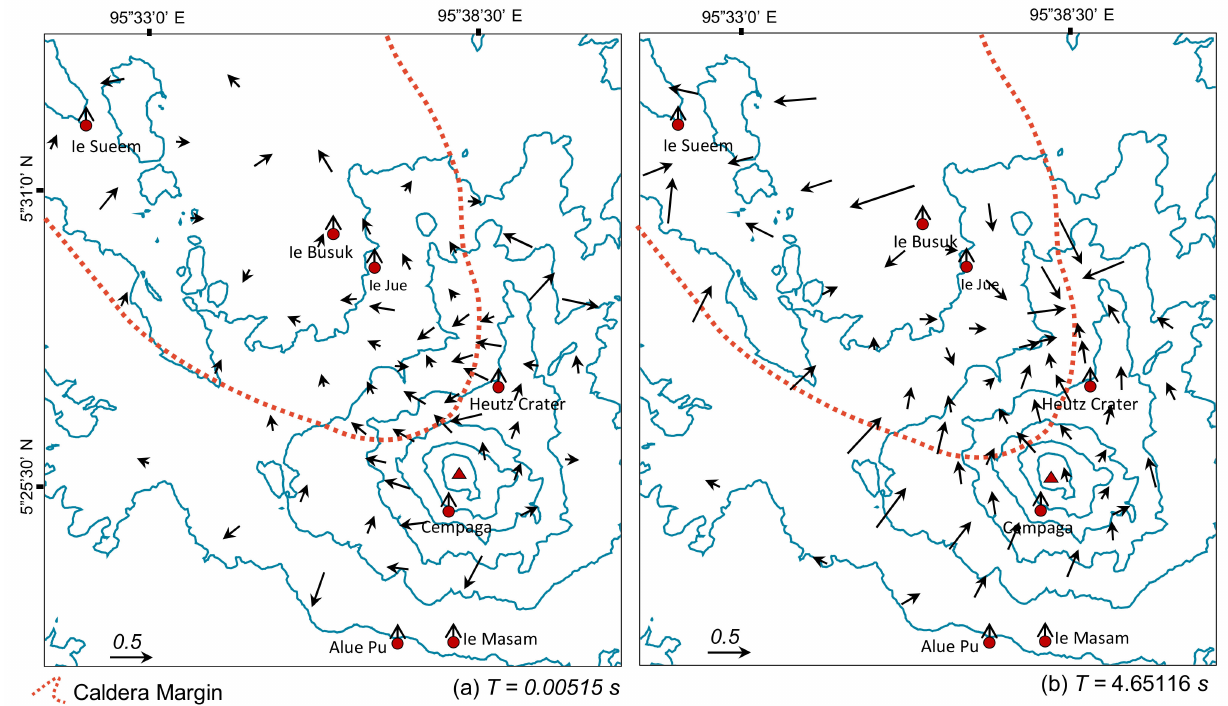
Figure 5. Tipper vector data showing the direction of the conductor at ( a ) a shallow depth ( T = 0.00515 s) and ( b ) a large depth ( T = 4.65116 s) below the surface. The blue lines represent the elevation contour with an interval of 300 m, while the red icons represent the manifestation